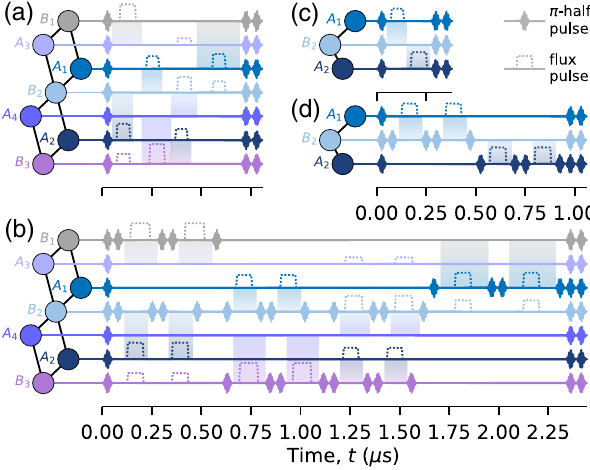
FIG. 11. Pulse sequences for implementing QAOA with p = 1. The shaded area around flux pulses illustrates which interac- tion they implement and how long buffer times before and after the flux pulse are chosen. (a) Direct implementation of the seven- qubit instance. (b) Decomposed implementation of the seven- qubit instance. (c) Direct implementation of the